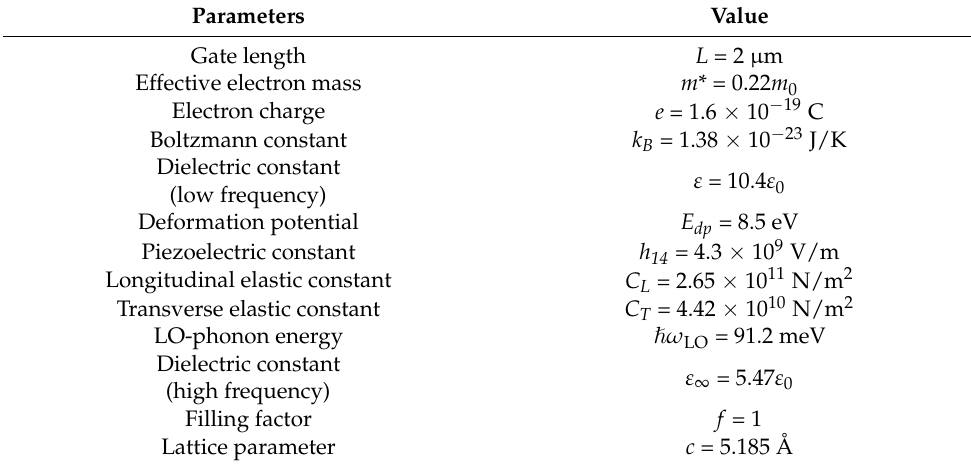
Table 1. Parameters used in calculation.